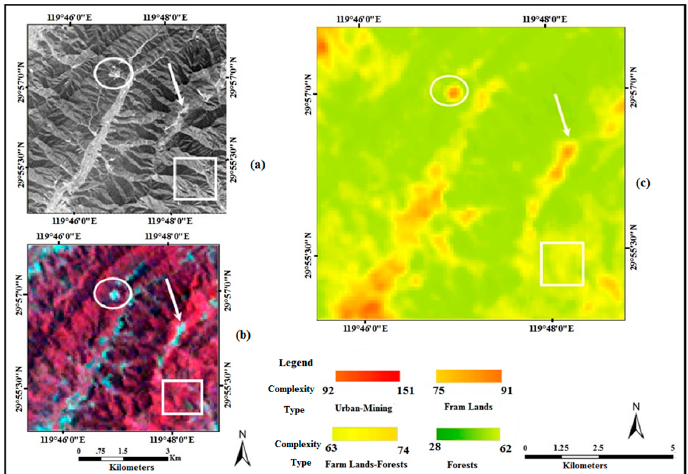
Figure 5. Maps of: ( a ) CORONA image; ( b ) Landsat MSS false color composite of bands RGB—NIR2,Red, and Green; and ( c ) map of land cover type and complexity in 1978 predicted by regression kriging.